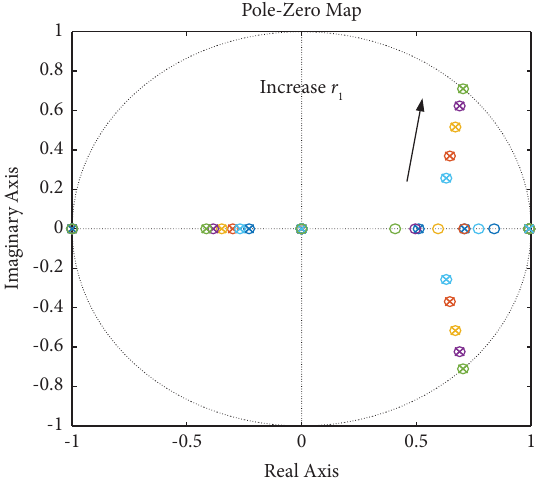
Figure 4: Closed-loop poles, when r